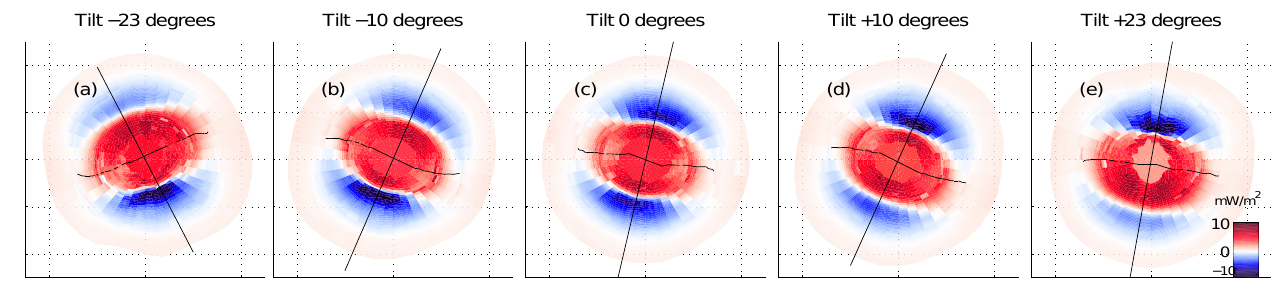
Fig. 7. Energy conversion surface density (Laitinen et al., 2006) in the GSE coordinate system, during the same times as presented in Fig. 6. The viewing angle is from the front of the magnetopause looking tailward, and the subsolar magnetopause is in the center of each diagram, while the the outer rim of the plotted surface is at X GSE = − 30 R E . The straight vertical black lines indicate the dipole orientation in GSM yz plane, while the black curve through the subsolar position is the average of the reconnection line computed with the four-field junction method (Laitinen et al.,